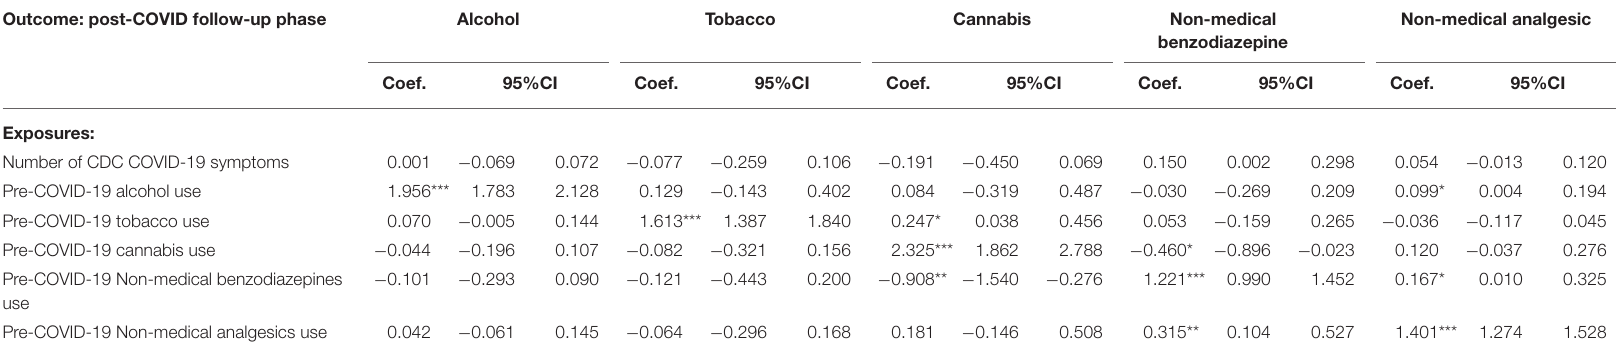
TABLE 4 | Results of the ordinal regression model for pot-COVID-19 follow-up phase substance use among 993 individuals who had mild COVID-19 in São Caetano do Sul, SP, Brazil. Outcome: post-COVID follow-up